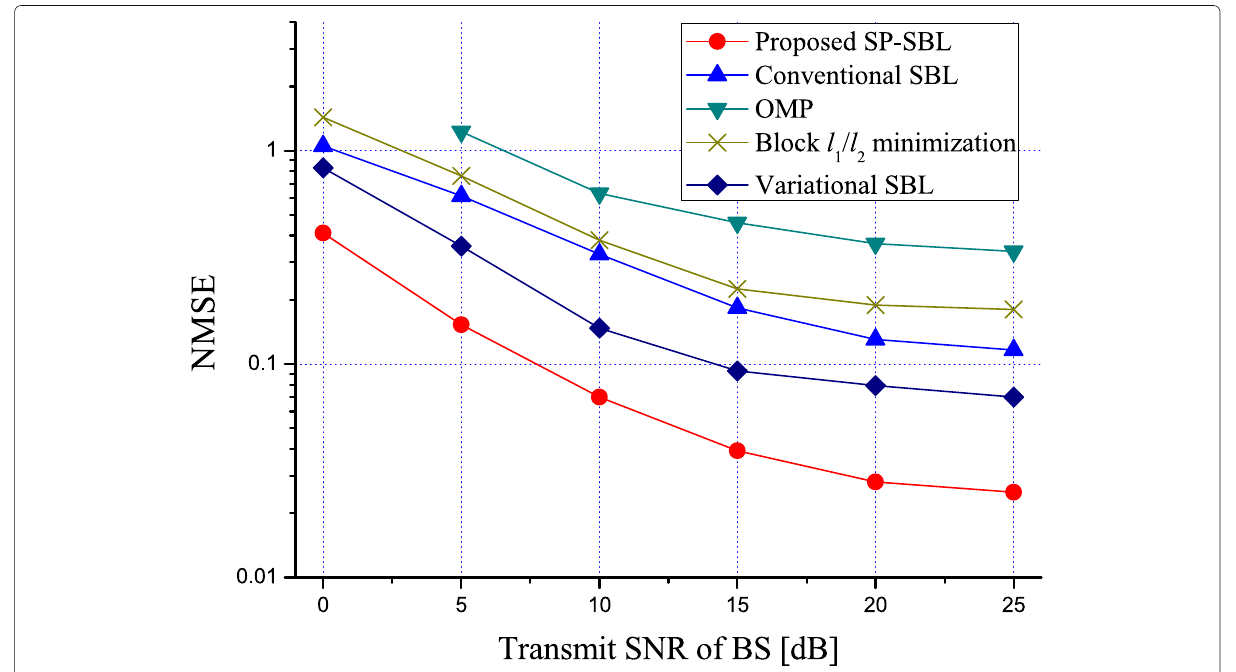
Fig. 3 NMSE performance for different transmit SNRs of BS, where N = 64 and M = 4. The length of pilot sequence is T = 16 and the angular spread is (cid:3) d = 5 ◦